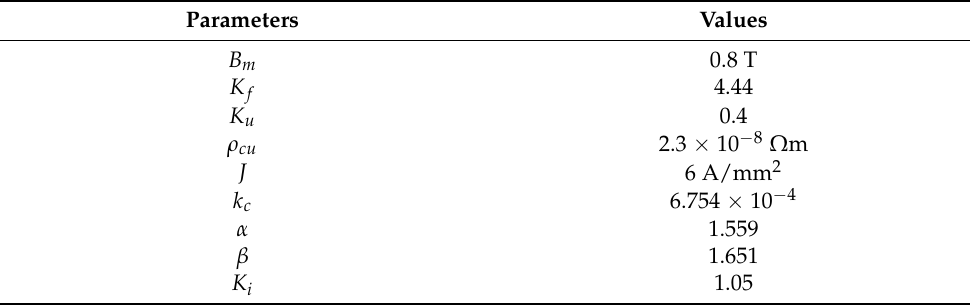
Table 2. Parameters for power losses calculation.